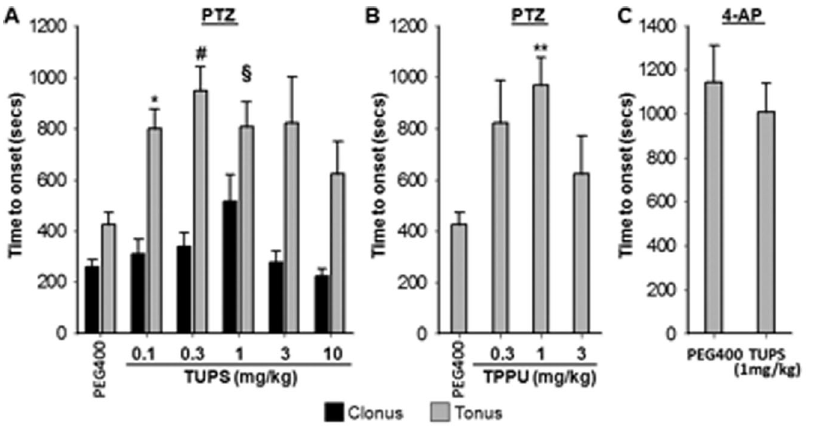
Figure 2. Potent inhibitors of sEH dose dependently delay onset of seizures induced by GABA antagonist. In parallel to observations with sEH 2 / 2 mice, small molecule inhibitors of sEH delay onset of tonic phase of seizure in wild type Swiss mice. In all three experiments sEHI were administered one hour prior to convulsants to allow absorption and distribution of the inhibitor. ( A ) TUPS was administered at a volume of 1 m L/g body weight by intraperitoneal route following completely dissolving it in PEG400. Subcutaneous PTZ induced tonic seizure is delayed by sEH inhibitor TUPS (n=8–22/group, Kruskal-Wallis One Way ANOVA on Ranks followed by Dunn’s multiple comparison, vehicle vs TUPS, *p=0.028, # p=0.008, 1 p=0.03), though onset of clonic seizure was not affected by inhibition of sEH. ( B ) In parallel to results obtained by TUPS, a structurally different sEHI, TPPU delayed the onset of tonic phase of PTZ induced seizure compared to vehicle (n=8–14/group, Kruskal-Wallis One Way ANOVA on Ranks followed by Dunn’s multiple comparison, vehicle vs TPPU, **p # 0.05). Clonic phase of seizures was not monitored in this experiment. See Table S1 for structure and potency information of TUPS and TPPU. ( C ) Seizures induced by 4-AP had a shorter onset in Swiss mice however consistent with data in Figure 1, an efficacious dose of TUPS did not significantly alter onset of seizure (n=8/group, Student’s t -test, p=0.49).